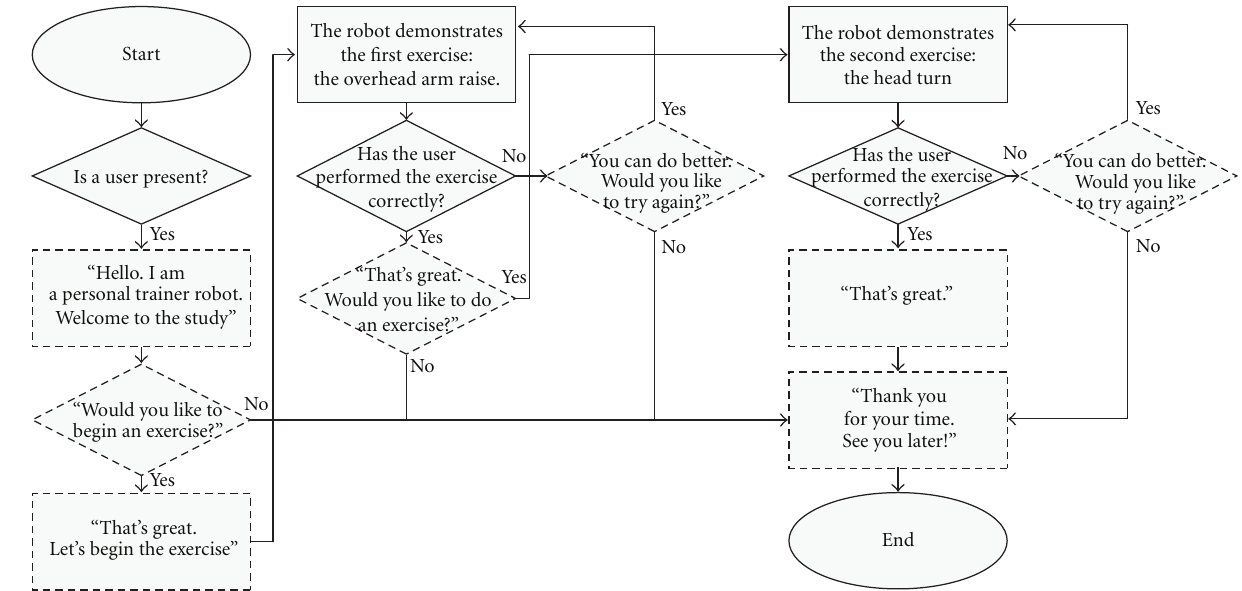
Figure 7: The initial interactive robotic framework is represented by a flowchart. When the vision-processing unit detects the presence of a user, it signals this information to the exercise adherence unit, which begins the interaction. If the user consents to begin an exercise, the robot first demonstrates it. Based on information from the vision-processing unit, the exercise adherence unit determines whether the user has completed an exercise correctly and, if the user has not, give the user an opportunity to be guided through the exercise again.